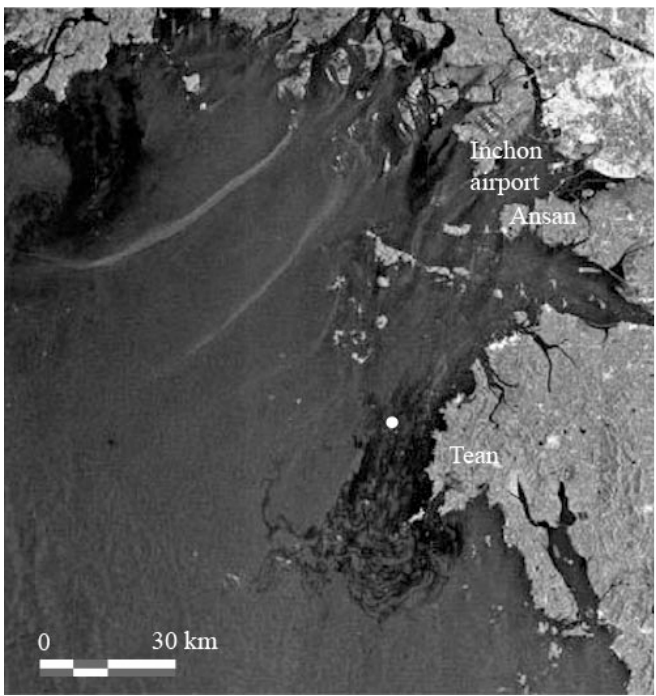
Figure 15. ENVISAT–ASAR C–band image, showing the Hebei Spirit tanker oil spill off the west coast of Korea. The dark areas around the position of the collision (white circle) is the spilled oil. The image was acquired 4 days after the collision.